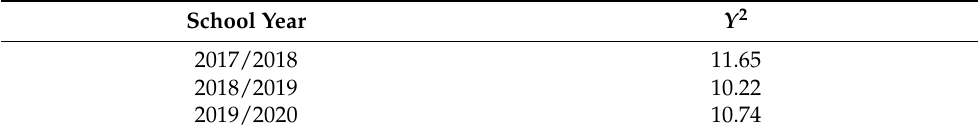
Table 1. Calculated values of testing statistics Y 2